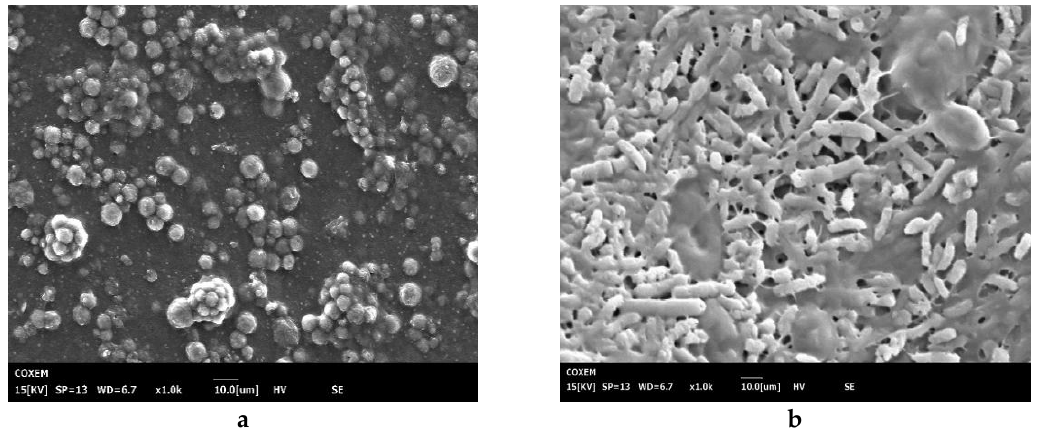
Figure 4. FTIR on M. aeruginosa : M. aeruginosa alone and ( a ) M. aeruginosa treated by P. chrysosporium ( b ).